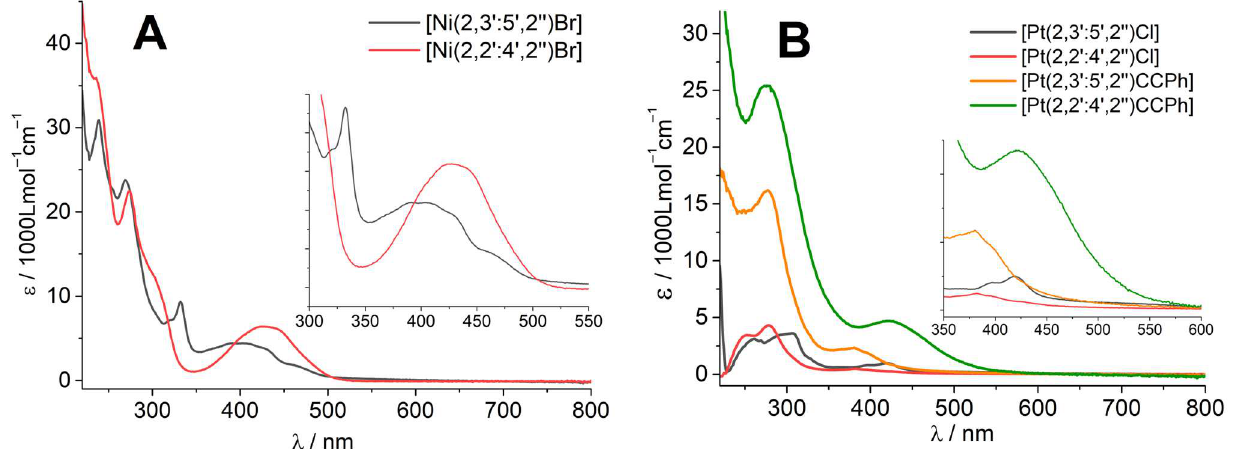
Figure 5. ( A ) UV-vis absorption spectra, wavelength (λ) against molar extinction coefficient (ε), of [Ni(Y-terpy)Br] (Y = 2,3′:5′,2″ ( Ni-1-Br ) and 2,2′:4′,2″ ( Ni-2-Br )) and ( B ) [Pt(Y-terpy)(X)] (Y = 2,3′:5′,2″ and 2,2′:4′,2″; X = Cl ( Pt-1- or -2-Cl ) or C≡CPh ( Pt-1- or -2-CC )) in THF solution.